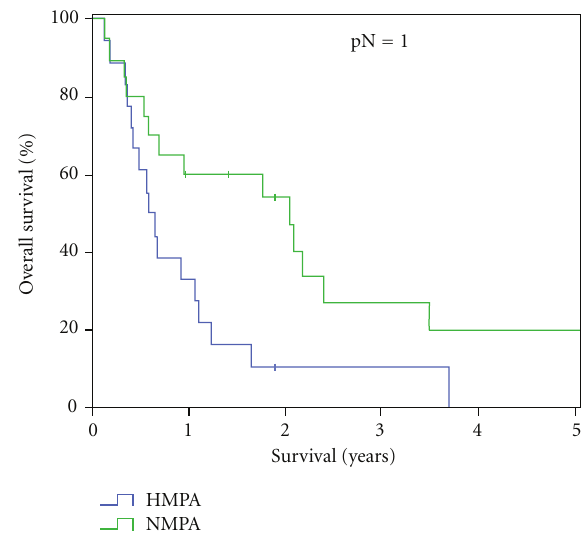
Figure 3: Patient survival in regards of positive lymph node status (pN1): HMPA versus